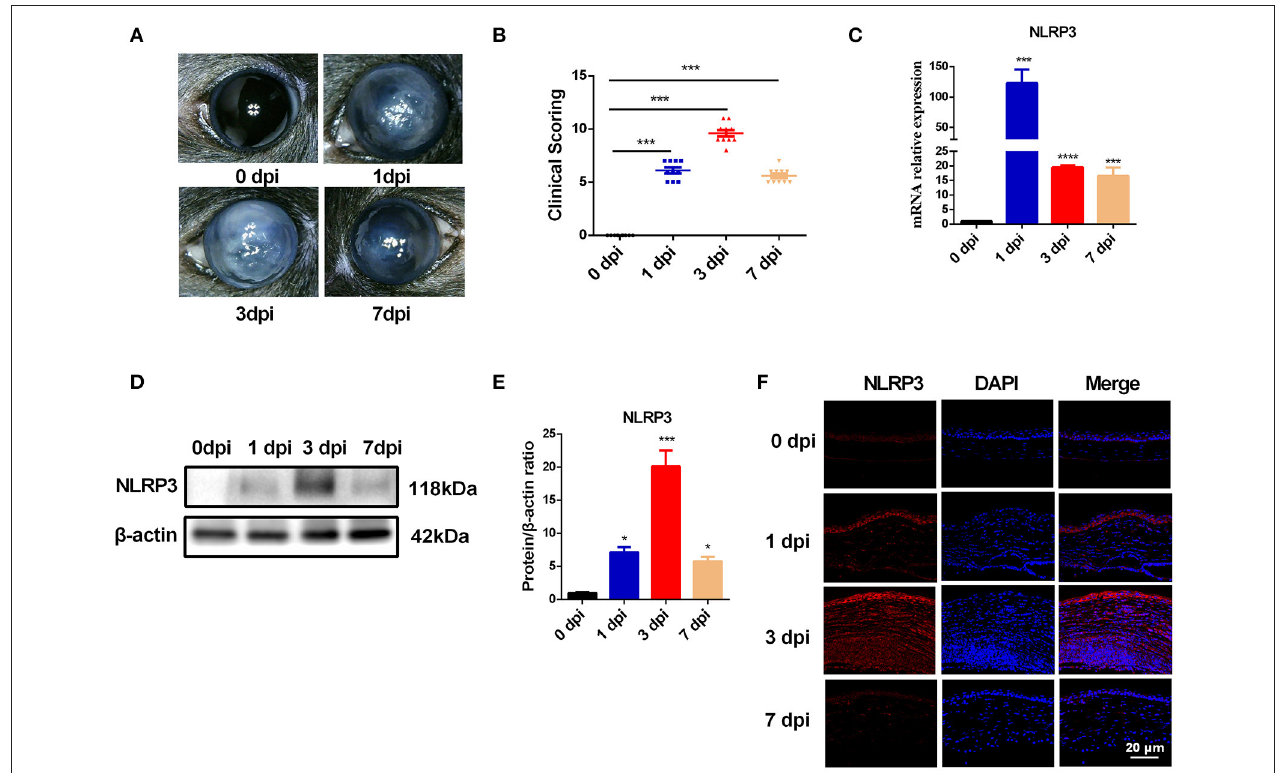
FIGURE 1 | The expression of NLRP3 is upregulated in mouse corneas of C . albicans keratitis. C57BL/6 mouse corneas were inoculated with 10 6 CFU of C. albicans or with sterile PBS and photographed daily after the inoculation. (A) The photographs of mouse C. albicans keratitis were taken by a slit lamp on 0 day (control), 1 day, 3 days, and 7 days post infection (dpi). (B) The clinical score of mouse C. albicans keratitis at different times during C. albicans infection ( n = 10). RT-qPCR analysis (C) , western blot (D,E) and immunofluorescence staining (F) showing the relative expression of NLRP3 in C. albicans -infected mouse corneas at mRNA ( n = 3) and protein levels ( n = 3), respectively. Scale bar = 20 µ m; magnification 400 × . All values are presented as mean ± SEM. * p < 0.05; *** p < 0.001; **** p < 0.0001 vs. control